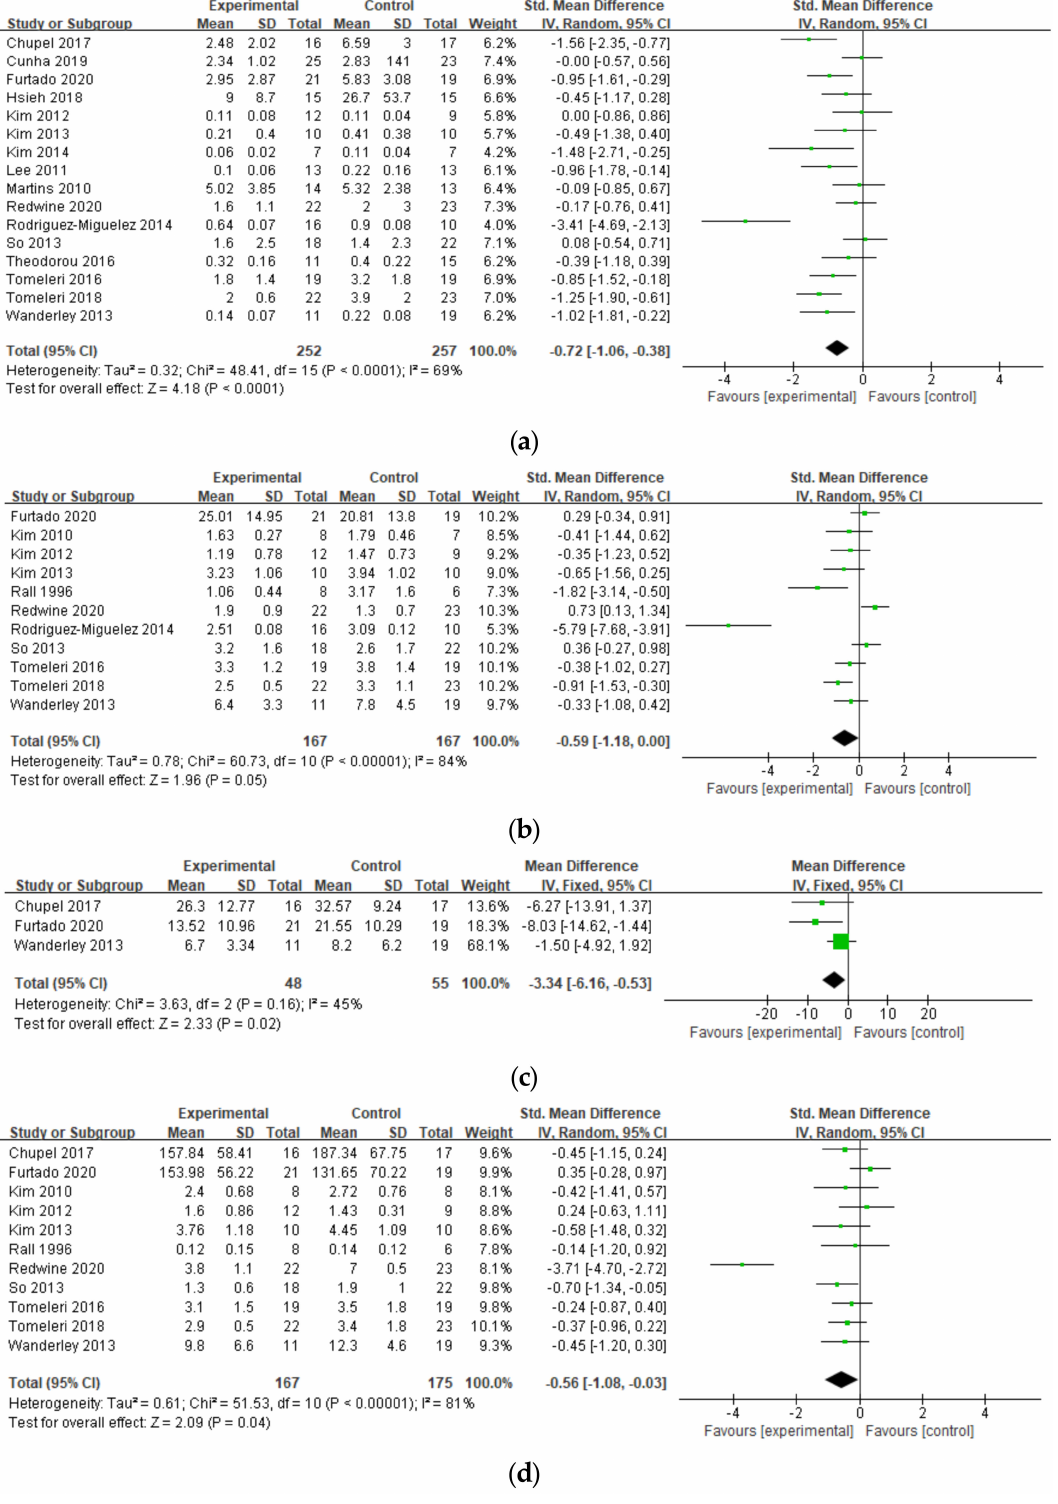
Figure 2. Forest plot of effect size by resistance training (RT) on ( a ) CRP, ( b ) IL-6, ( c ) IL-10, and ( d ) TNF- α . Three studies examined IL-10, with a large effect size of − 3.34 (95% CI = − 6.16 to − 0.53, p = 0.002) and low heterogeneity ( I 2 = 45%). Unfortunately, subgroup analysis was not possible for IL-10 due to its heterogeneity between